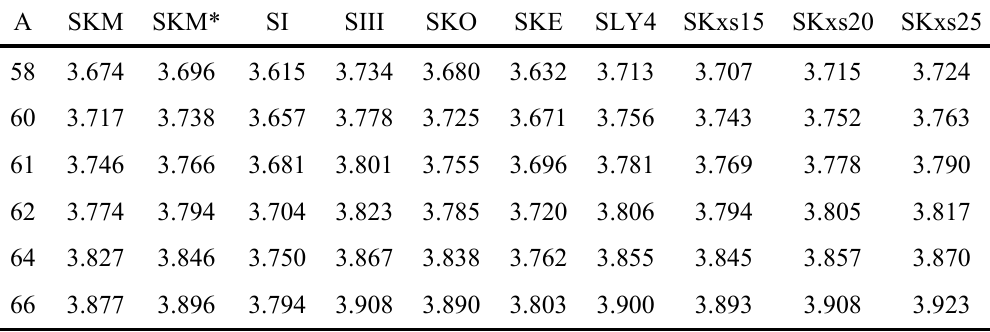
Table 5: Calculated mass rms radii (fm) for the selected